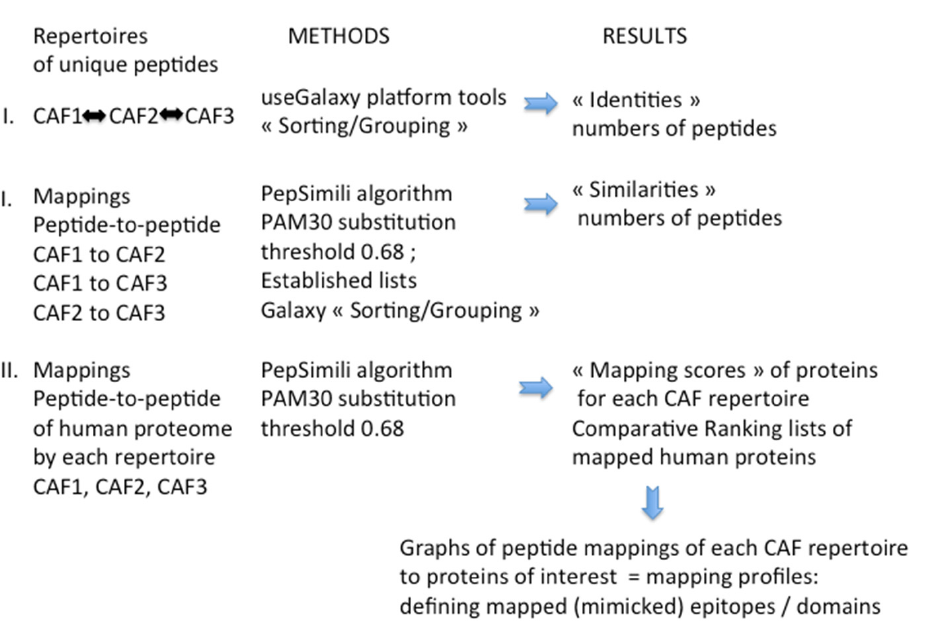
Figure 1. Overview of experimental design. The bioinformatics study of the three CAF peptide repertoires was performed in a stepwise approach. The main steps are indicated by I/II/III. The various methods applied that led to the generated results are summarized.